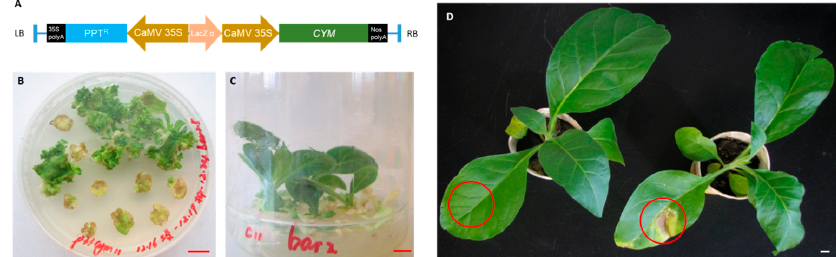
Figure 1. Generation of transgenic plants. ( A ) The T-DNA insert in the bovine preprochymosin (CYM) expression vector p33cym11. LB and RB represent the left and right border of T-DNA region; PPT R represents the glufosinate-resistance encoding gene; CaMV 35S and 35S polyA represent the promoter and the terminator of cauliflower mosaic virus 35S gene respectively; Lac Z α encodes the α -fragment of the enzymy β -galactosidase; Nos polyA represents the terminator of the nopaline synthase gene; ( B ) Resistant shoots regenerated on a selection medium; ( C ) Resistant shoots rooting on rooting medium; ( D ) Plants grown in the greenhouse. After wiping glufosinate solution on the circled portions of the leaves, no necrotic lesions were detected for the transgenic plant ( left ) but obvious symptoms were observed in the wild type ( right ). Scale bars = 1 cm.